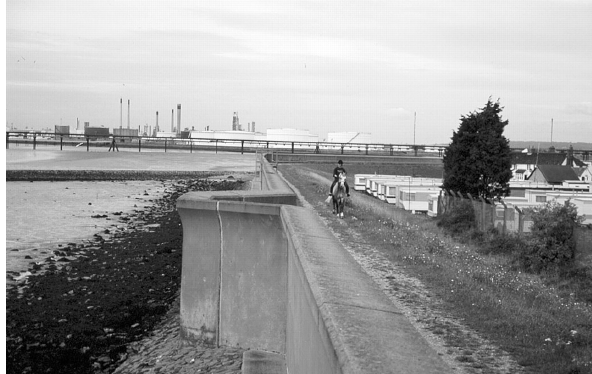
Fig. 9. Age and sex of the people who died in the 2010 coastal floods caused by Xynthia. (Source: Based on data collated by Université Paul-Valéry Montpellier III, 2010).